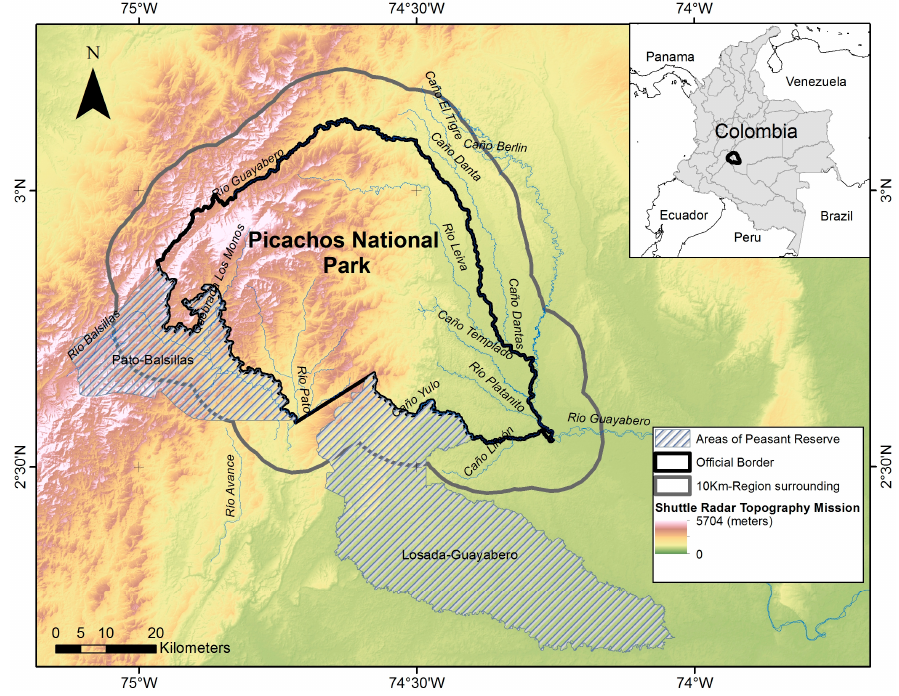
Figure 1. The study area of Picachos National Park is located in central Colombia at the northern extent of the Andes mountain range. of the Andes mountain